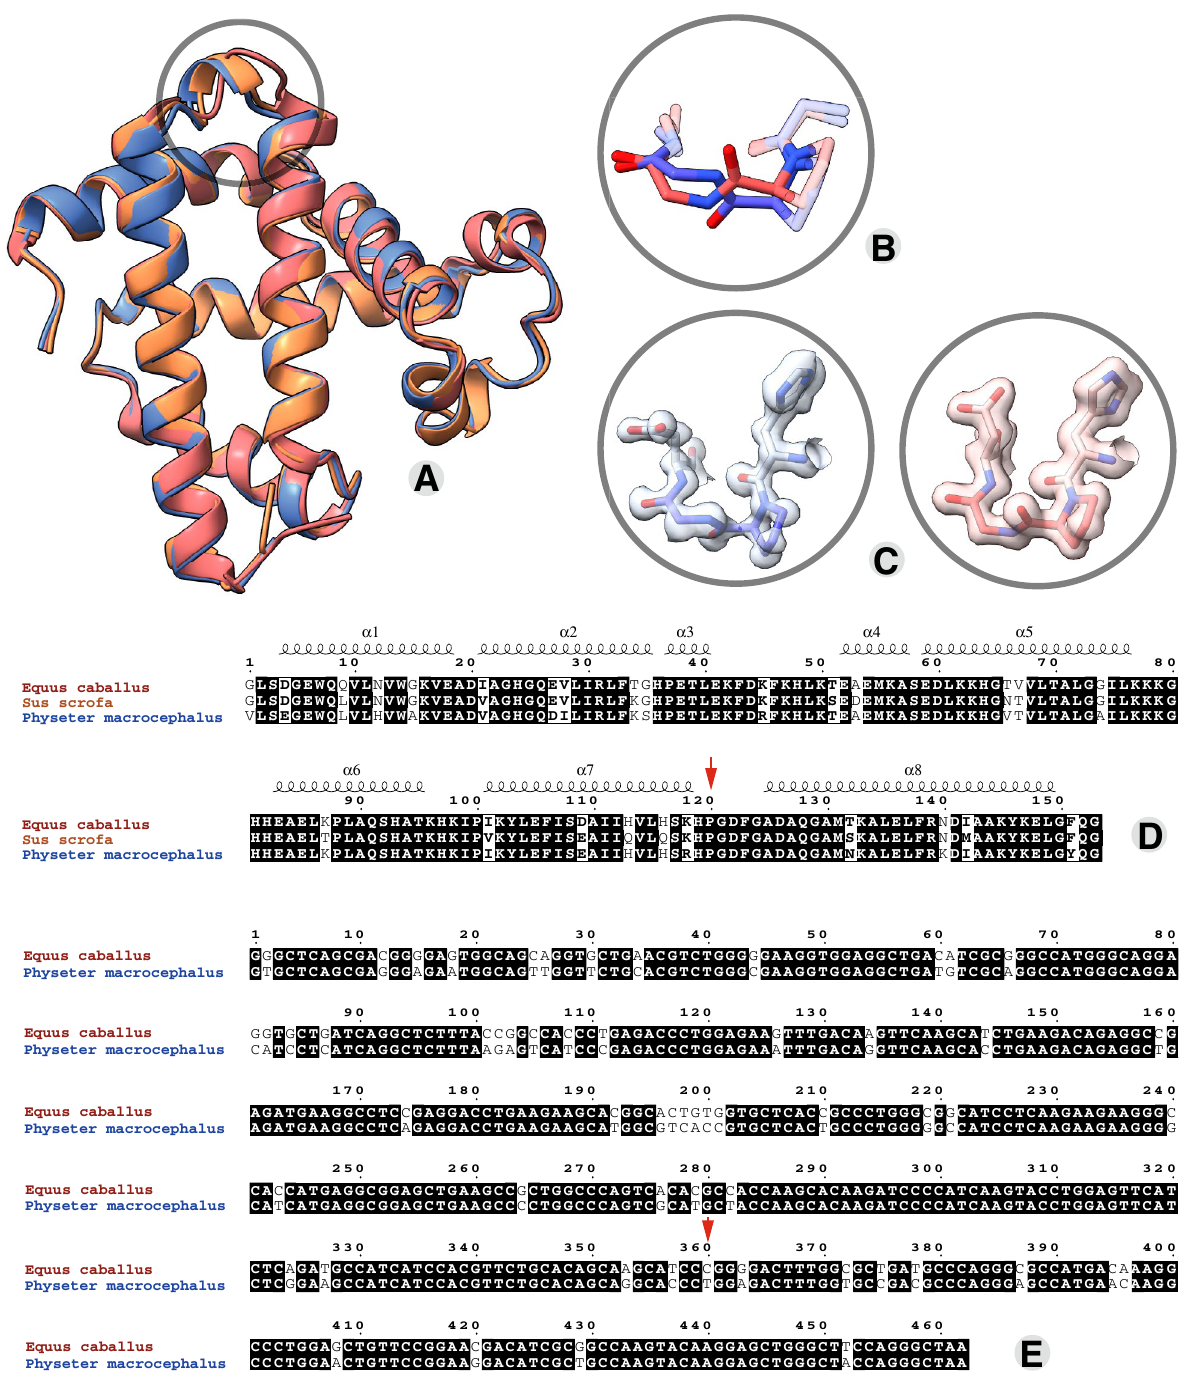
Figure 1. Horse heart myoglobin adopts an alternate turn conformation which is not explainable at the sequence level. Eq_ myoglobin (1GJN, maroon), Phy_ myoglobin (1A6K, blue) and Sus_ myoglobin (1MWC, orange) structure alignment ( A ), highlighting the altered Eq_ myoglobin turn conformation when the loops bridging helices G and H are locally aligned ( B ). This region of the protein chain is well-defined and distinct in the electron density maps ( C ). High identity is demonstrated in alignment of the amino acid sequence ( D ) and alignment of the coding sequences highlights synonymous differences (different coding sequences translating to the same amino acid), including on the loop itself ( E ). Alternate turn location is indicated with an